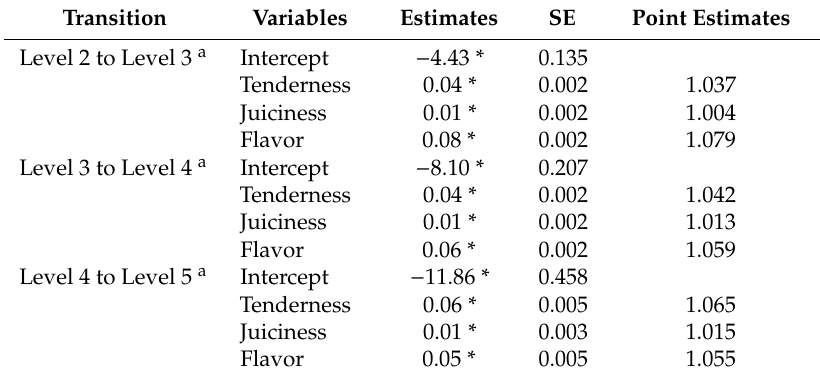
Table 14. Conditional logit